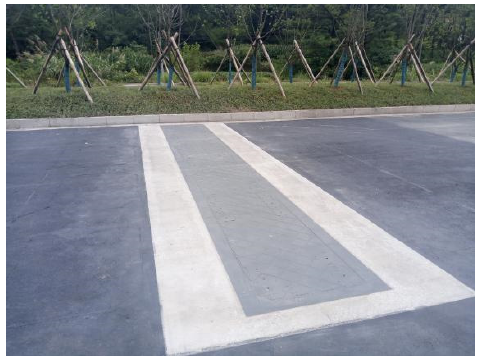
Figure 2. Weighing platform.